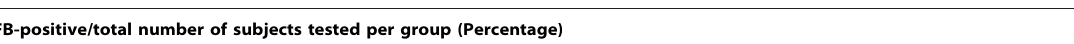
AFB-positive/total number of subjects tested per group (Percentage) No TB